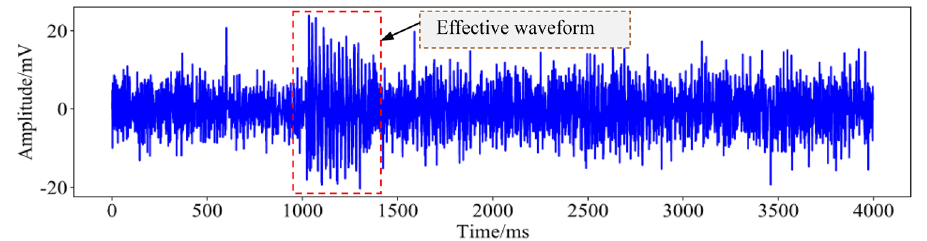
Figure 1. Effective waveform drowned out by noise.